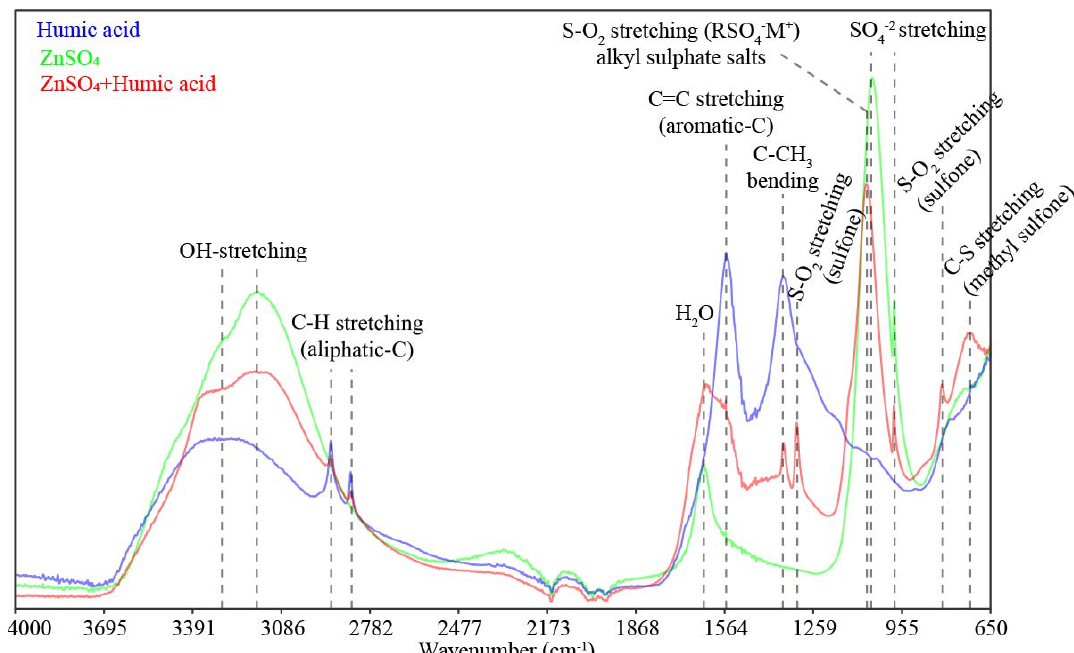
Figure 6. Peaks and the main features of chemical groups recorded by the Fourier-transform infrared spectroscopy analysis with attenuated total reflectance (FTIR–ATR). FTIR bands were assigned for pure samples of ZnSO 4 (Heptahydrate zinc sulfate), humic acid and the mixture of ZnSO 4 with humic acid.